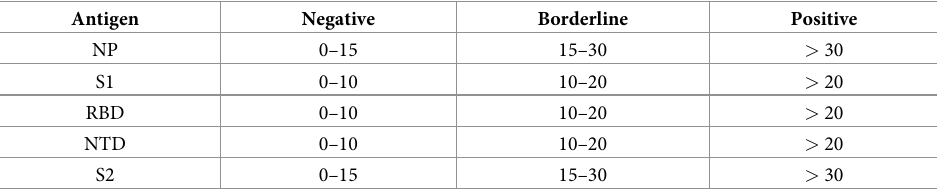
Table 2. Mean signal intensity cut-offs for individual antigens in arbitrary units